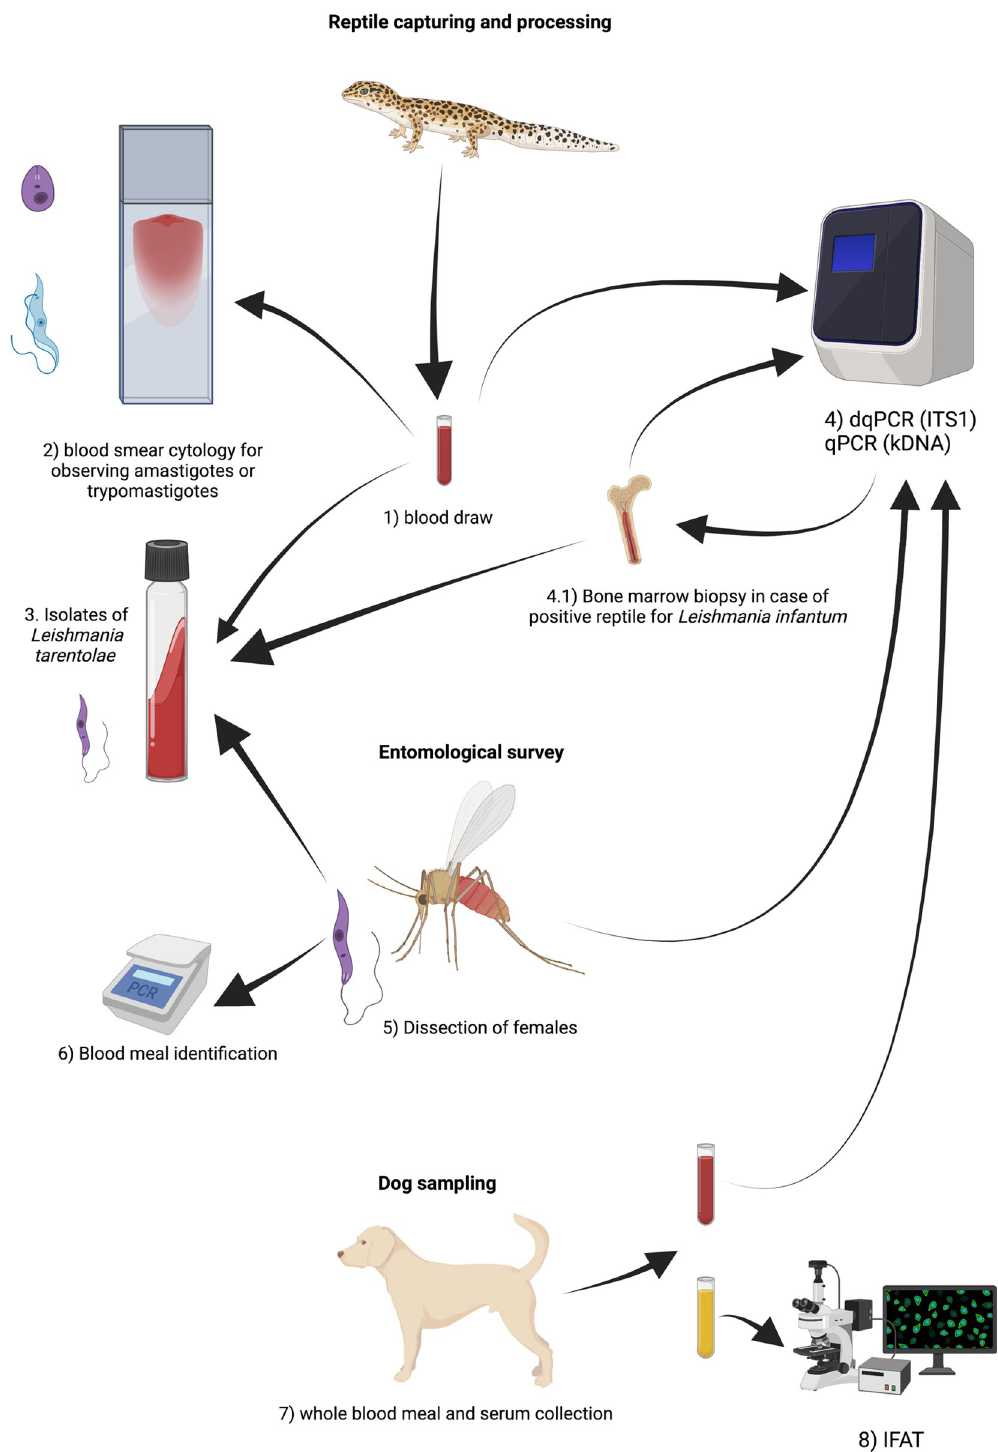
Fig 1. Flowchart of methods and samples used, divided by sections: reptile capturing and processing, entomological survey and dog sampling. Created in: https://biorender.com/.